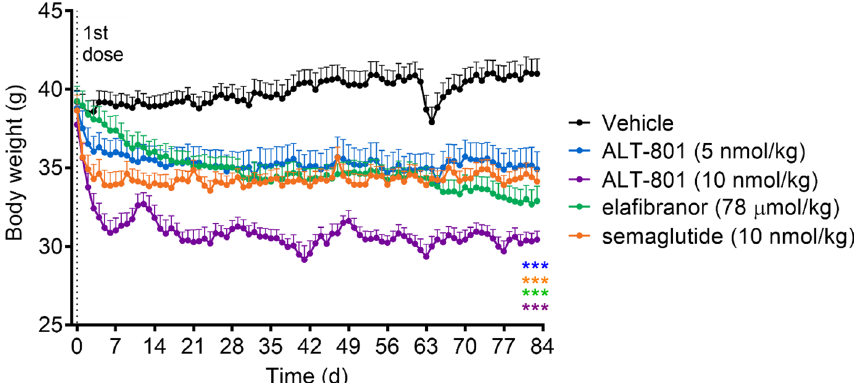
Figure 2. Body weight of treatment groups. DIO-NASH mice were treated daily with vehicle (s.c.), ALT-801 (5 and 10 nmol/kg, s.c.), elafibranor (78 μmol/kg, oral) or semaglutide (10 nmol/kg, s.c.). Body weight was recorded daily. For ALT-801 and semaglutide, rapid body weight decreases occurred within 1–2 weeks and stabilized. Elafibranor (PPAR-α/δ agonist) causes weight loss in rodents but not in clinical trials. On day 63 vehicle animals were mis-dosed with ALT-801 10 nmol/kg, causing a rapid ~ 8% body weight decrease, which resolved over a period of days. ALT-801 treatment (10 nmol/kg) reduced body weight to the lean normal range (~ 30 g; − 25%). Data are expressed as mean ± SEM (n = 11–12). *** p ≤ 0.001 vs. vehicle